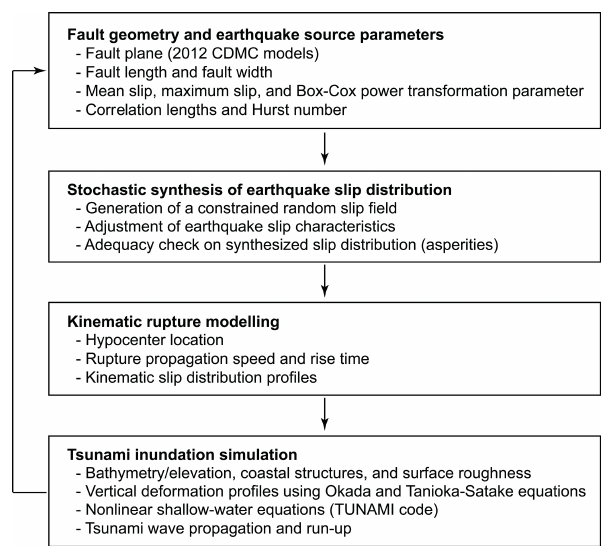
Figure 3. Numerical steps of stochastic tsunami